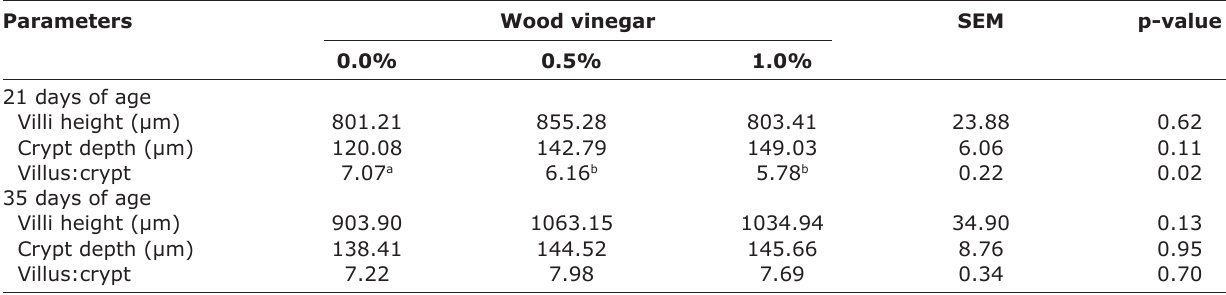
Table-2: Effect of drinking water supplemented with wood vinegar on intestinal morphology of broiler chickens.